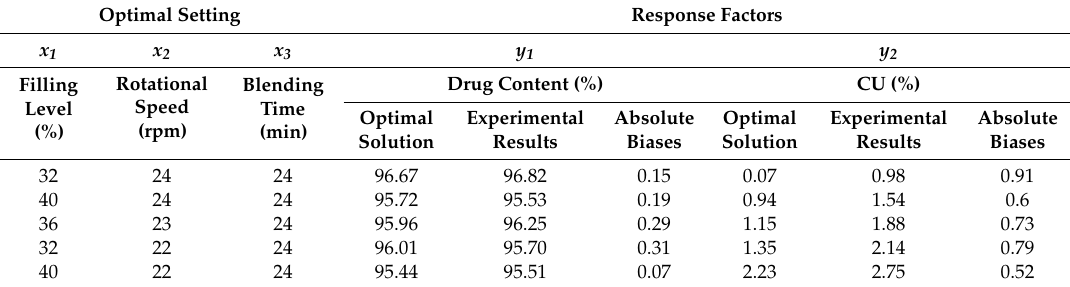
Figure 5. Operating spaces derived by applying Monte Carlo simulation to corresponding design spaces: blending time at ( a ) 9 min, ( b ) 16.5 min, and ( c ) 24 min. The green spaces denote parts with a failure probability of less than 1% of the target values of IQAs. Table 5. Optimal settings, optimal solution, and experimental results for responses in operating space.